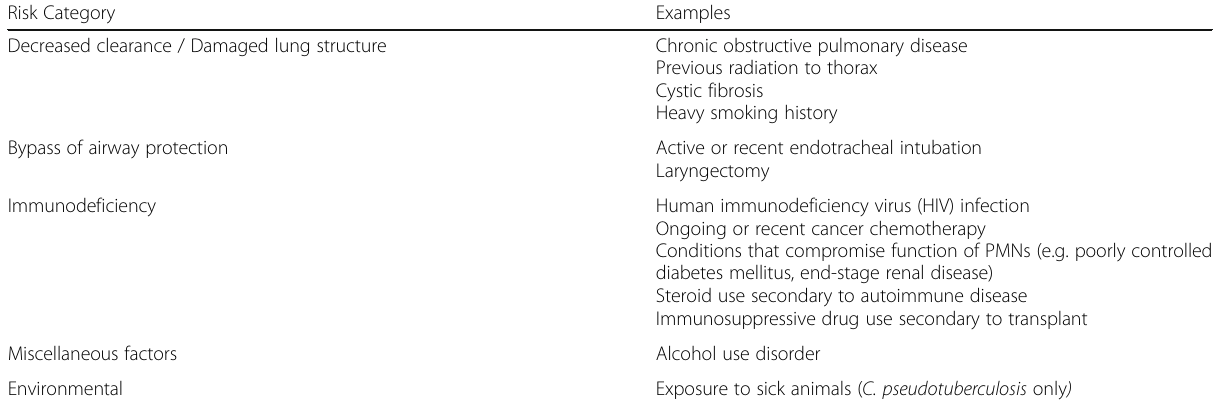
Table 2 Risk factors in reported cases of Corynebacterial pneumonia Risk